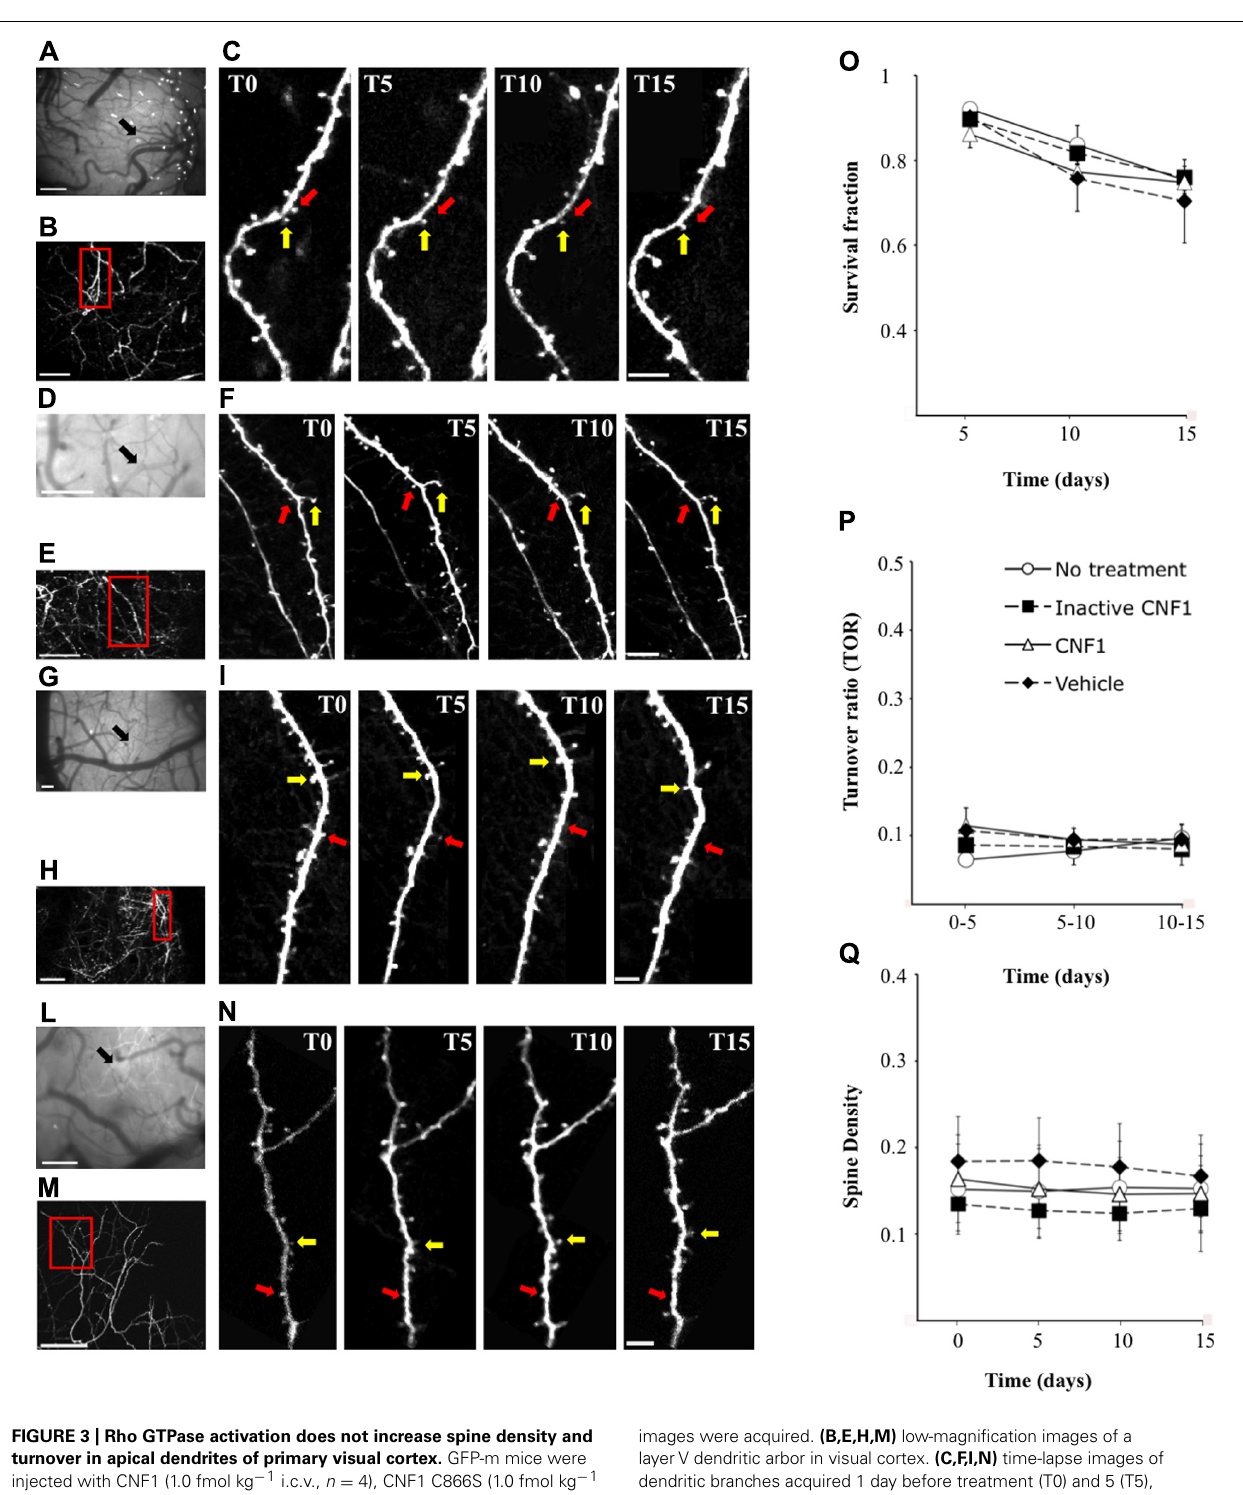
images were acquired. (B,E,H,M) low-magnification images of a layerV dendritic arbor in visual cortex. (C,F,I,N) time-lapse images of dendritic branches acquired 1 day before treatment (T0) and 5 (T5), 10 (T10), and 15 (T15) days after injection (from boxed regions in B,E,H,M , respectively). Figures show an example of persistent (yellow arrows) and transient spines (red arrows). Mean survival fraction (O) , mean turnover ratios (P) and mean spine density (Q) are plotted as a function of time. Scale bars = 200 μ m (A,D,G,L) ; 100 μ m (B,E,H,M) ; 5 μ m (C,F,I,N)